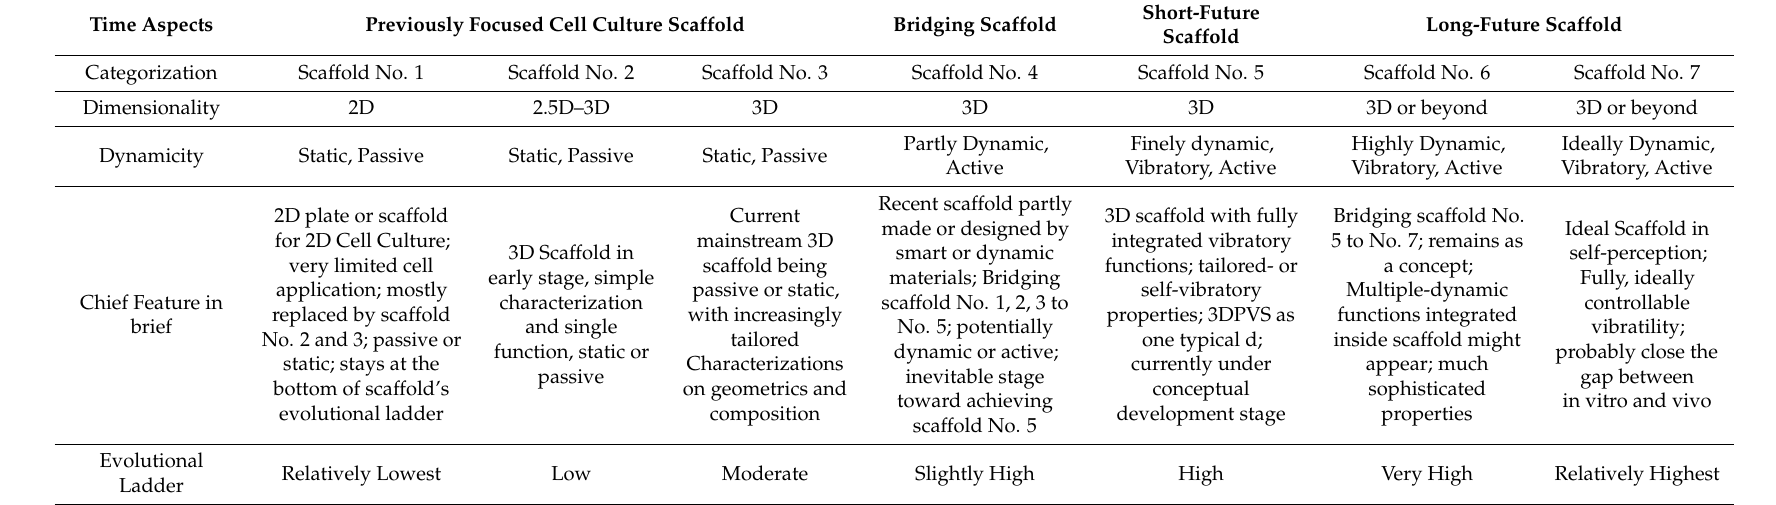
Table 1. Summarizing table of scaffold categorization via introducing the language of